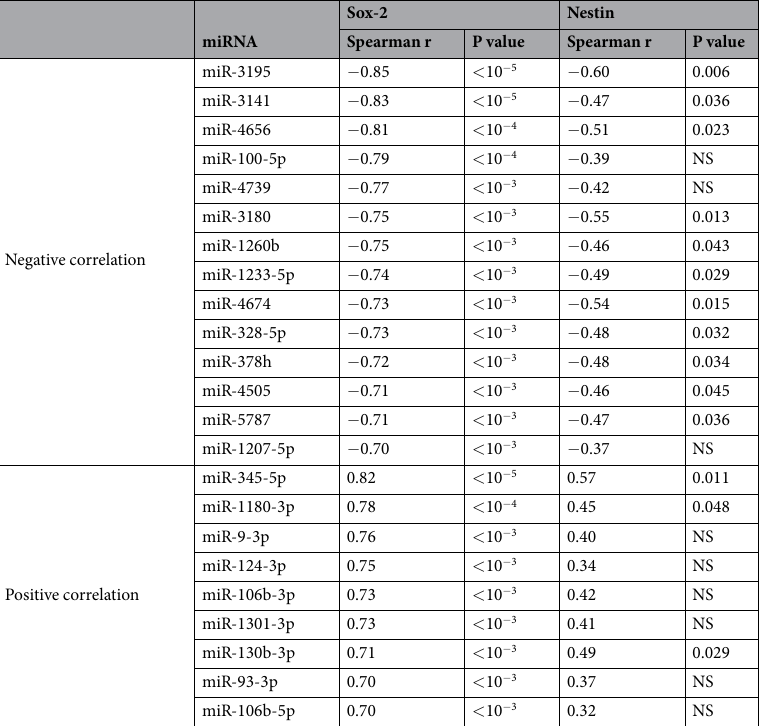
Sox-2 Nestin miRNA Spearman r P value Spearman r P value miR-3195 − 0.85